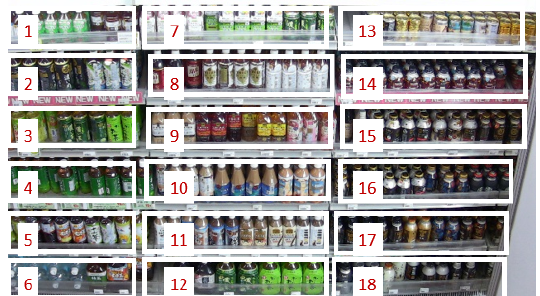
Figure 10. Predefined monitoring areas with shelf number.